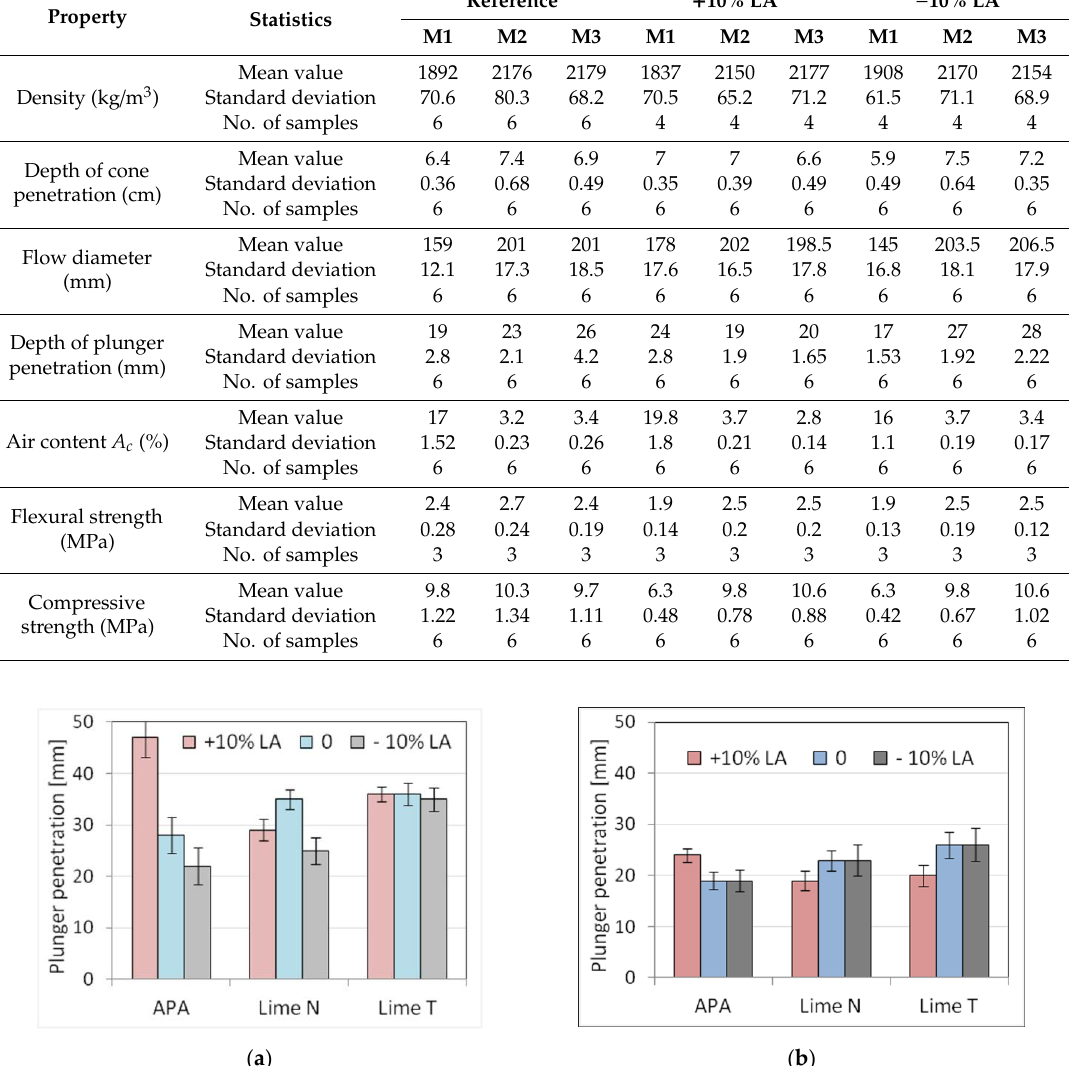
Table 10. Results of tests of the influence of mistakes in dosing of lime / APA on properties of masonry mortars. Property Statistics